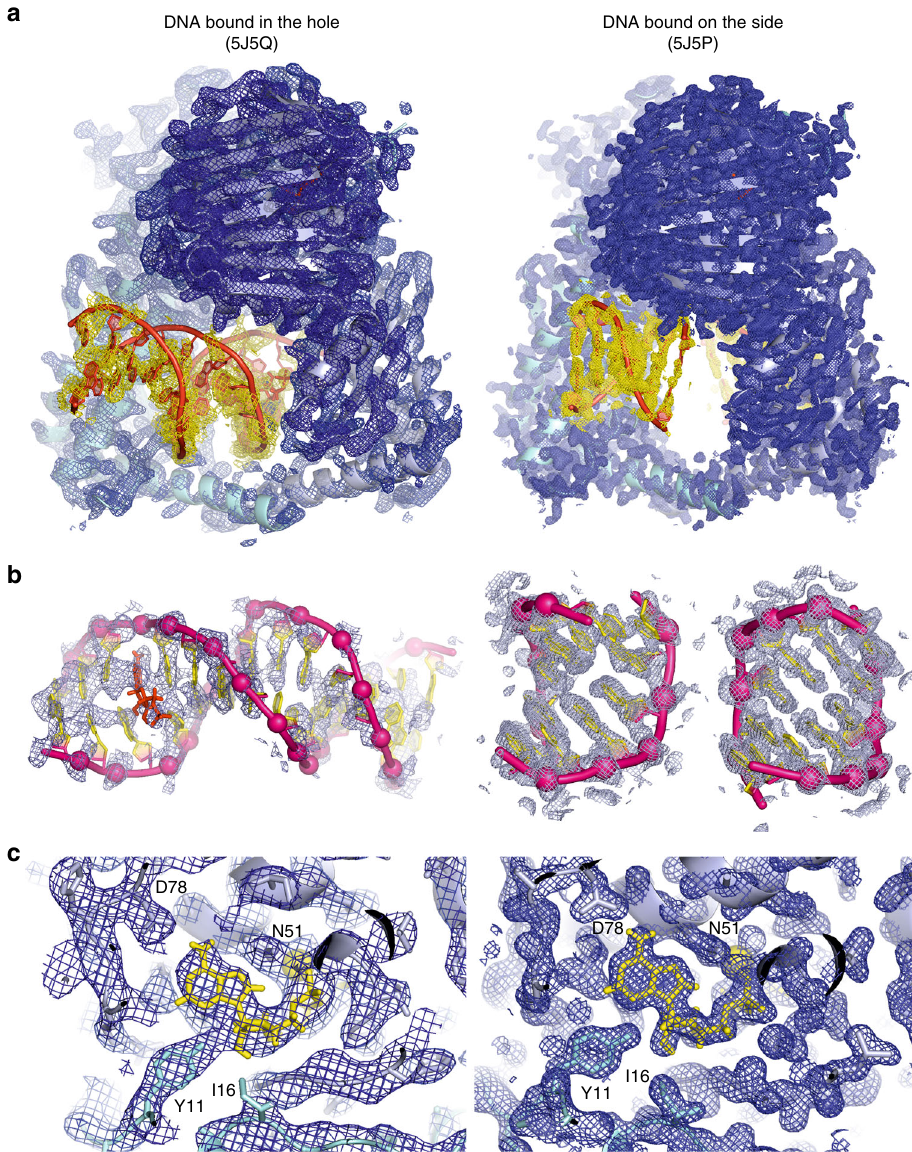
Fig. 4 Comparison of hole-bound and side-bound ParE44-DNA structures. Composite omit electron density maps (2 F obs − F calc ) were contoured around a the entire molecular structure, b the bound DNA and c the bound AMP-PNP in the ATP binding site. Structures on the left-hand side represent the complex with the DNA bound in the hole formed by the ParE44 dimer. Structures on the right-hand side represent the side-bound DNA complex. In a the electron density map is contoured at 1.5 and 1.0 σ levels for protein and DNA in blue and yellow colours, respectively. In b the electron density map is contoured at 1.0 σ level and is in light blue. In c the electron density map is contoured at the 1.5 σ level only and is in blue. In a the protein and DNA are displayed in cartoon mode in light blue/cyan and red, respectively. In b the DNA backbone is in pink with phosphates indicated by spheres, the DNA bases are in yellow and the intercalated molecule X is in red. In c the bound AMP-PNP molecule and the coordinated magnesium are shown in yellow, while the protein residues are in light blue/cyan. Magnesium is shown as a sphere, side chains and AMP-PNP are shown using stick representation and the protein backbone is displayed in cartoon